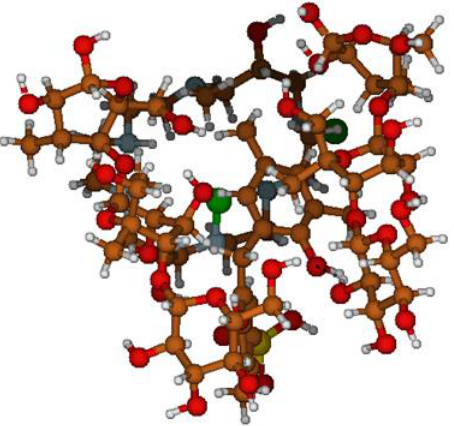
Figure 5. Model of the mosaic membrane Polikon AC.